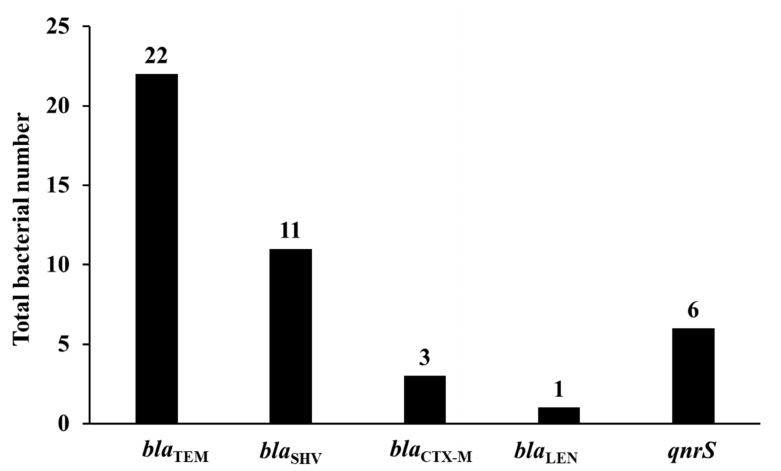
Figure 3. Detected antimicrobial resistance genes. Regarding β -lactamase encoding genes, bla TEM was identified in 22 isolates (29% 95% CI 20–40%) of the isolates, followed by bla SHV identified in 11 isolates (14.5%, 95% CI 8.3–24.1%), bla CTX-M identified in three isolates (4%, 95% CI 1.4–11%), and finally, a single isolate harbored bla LEN-13/55 (1.3%, 95% CI 0.2–7.1%). qnrS was the only identified PMQR in six isolates (7.9%, 95% CI